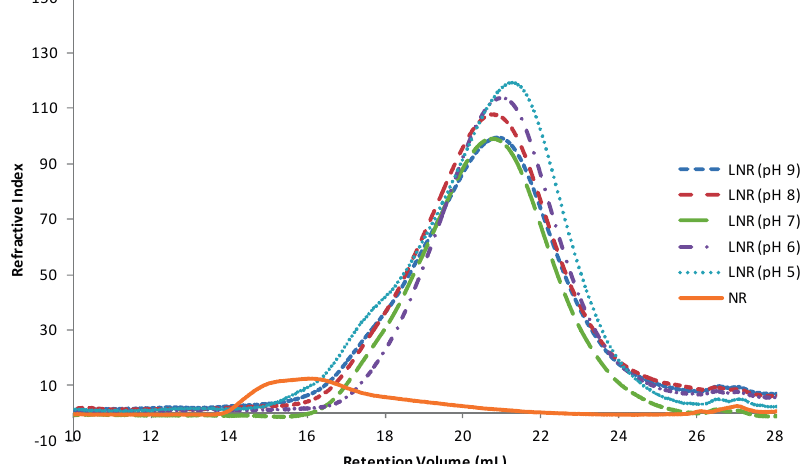
Figure 10. Gel permeation chromatography (GPC) chromatograms of NR and LNR samples prepared at various